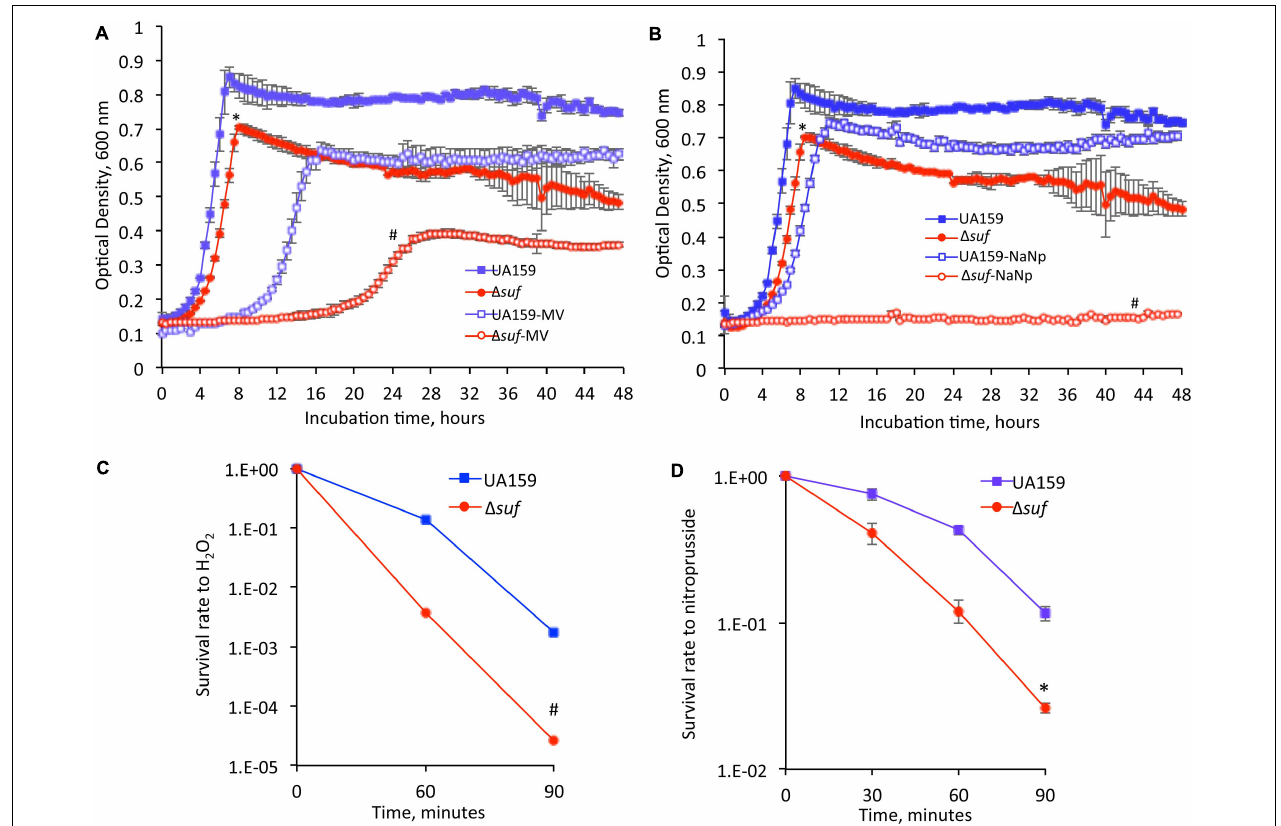
FIGURE 4 | Oxidative and nitrosative stress challenging assays. When grown in the presence of methyl viologen (MV) at 25 mM (A) and sodium nitroprusside (NaNp) at 2 mM (B) , the (cid:49) suf::kan r mutant ( (cid:49) suf ), showed significantly reduced growth rate and especially, the culture density as measured using a Bioscreen C, as compared to the wild-type. Symbol * and # indicates statistical significance at P < 0.05 and < 0.001, respectively. Following incubation in the presence of hydrogen peroxide (H 2 O 2 ) at 58 mM (C) or sodium nitroprusside at 50 mM (D) , the (cid:49) suf mutant showed 2-log and 2-fold reduction, respectively, when compared to the wild-type. Symbol * and # indicates significant differences at P < 0.001 and < 0.05,